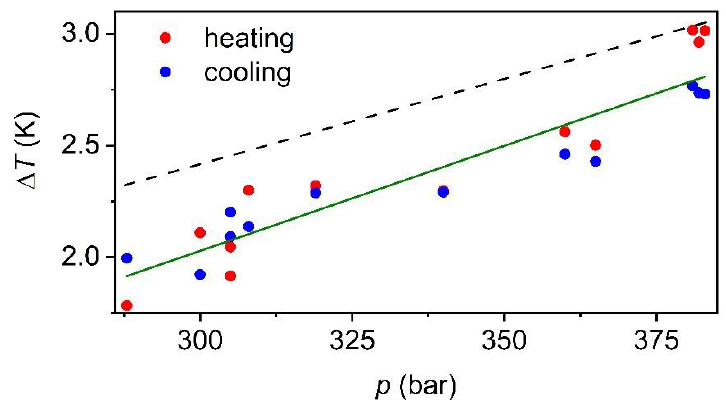
Figure 4. Temperature change (Δ T ) as a function of the pressure-induced by different footstep forces from 290 to 380 bar. Note: green solid line represents the linear trend of the here obtained experimental data for trans-1,4-polyisoprene. Meanwhile, the black dashed line represents the thermodynamic model reported for the isomer compound cis-1,4-polyisoprene [41].